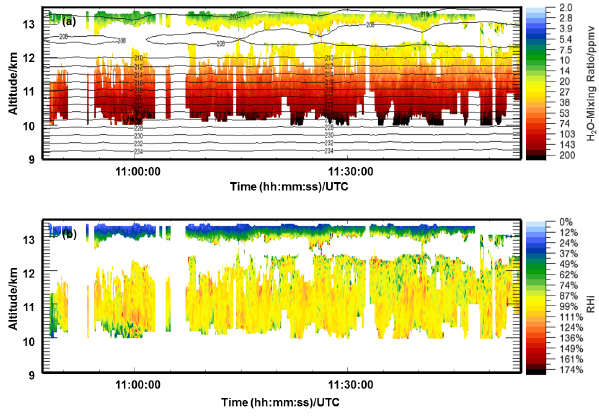
Figure 7. (a) Water vapour volume mixing ratio as measured with WALES on HALO and contour lines of ECMWF tempera- ture. (b) Relative humidity over ice from combined WALES and ECMWF data. In the white areas no trustworthy measurements are available due to signal overload and strong